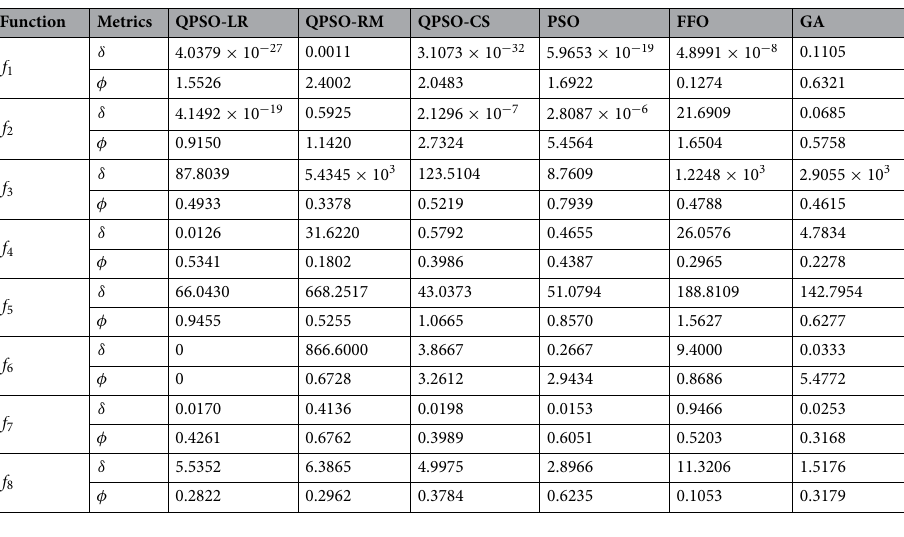
Table 1. Accuracy and precision metrics for unimodal benchmark functions with N = 30, Tmax = 1000 and Texp =